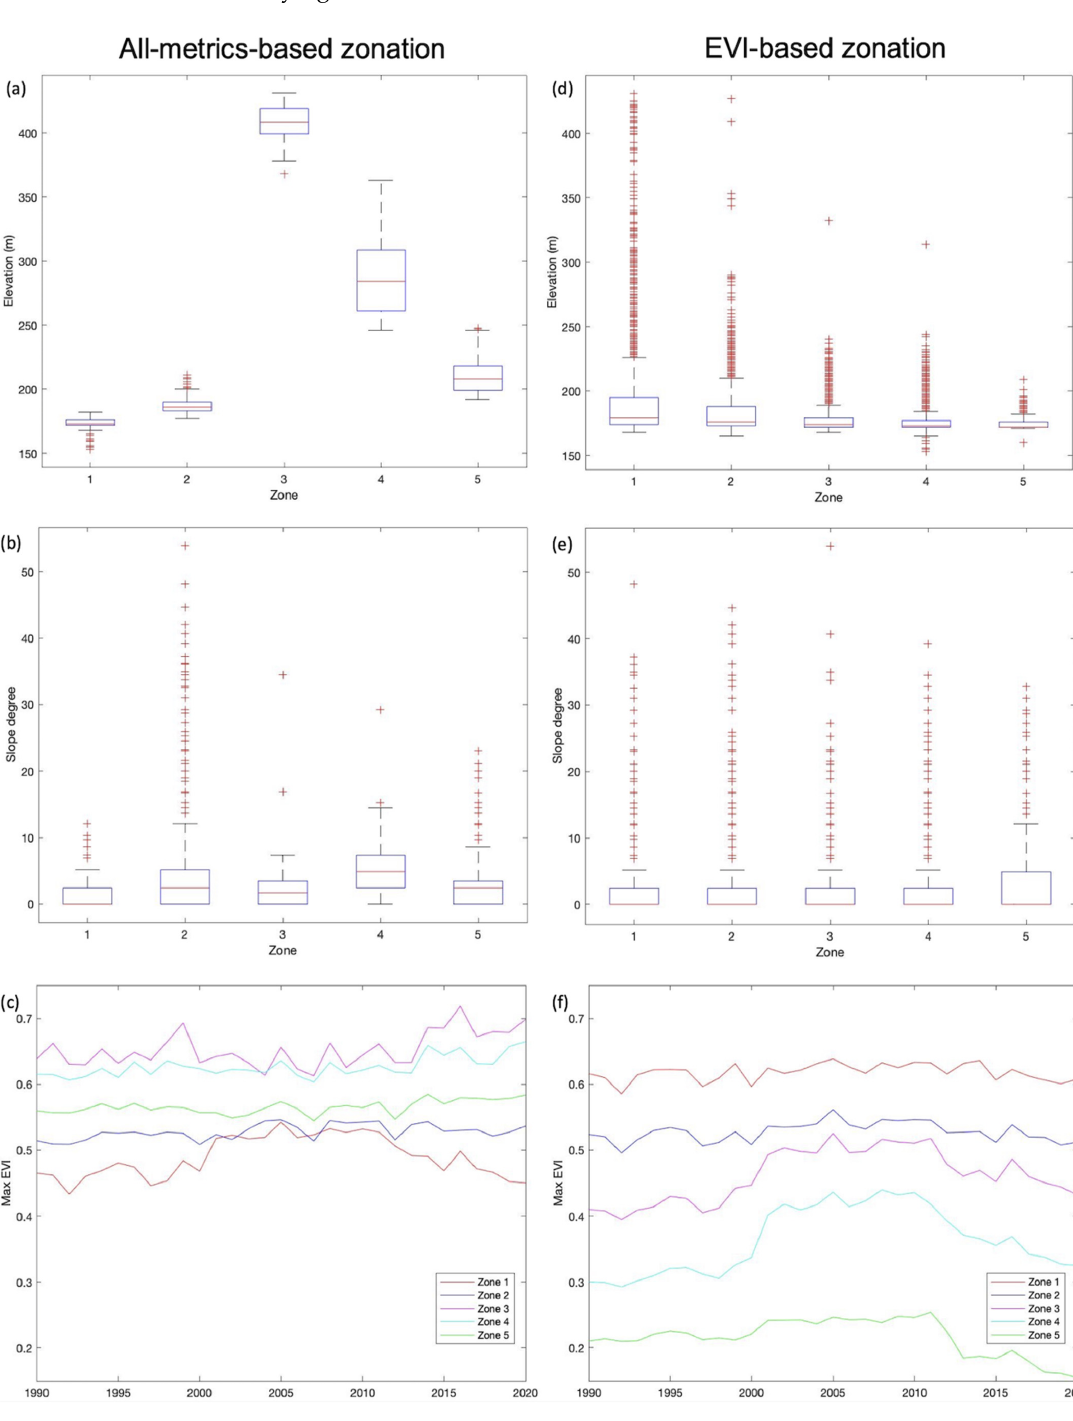
Figure 7. Distribution of the variables within the clusters of two zonations: the left column is all-metrics-based zonation, the right column is EVI-based zonation. The variables are: ( a , d ) the elevation; ( b , e ) the slope; ( c , f ) yearly mean EVI for the period 1990–2020. Elevation, slope, and EVI are all statistically different in each